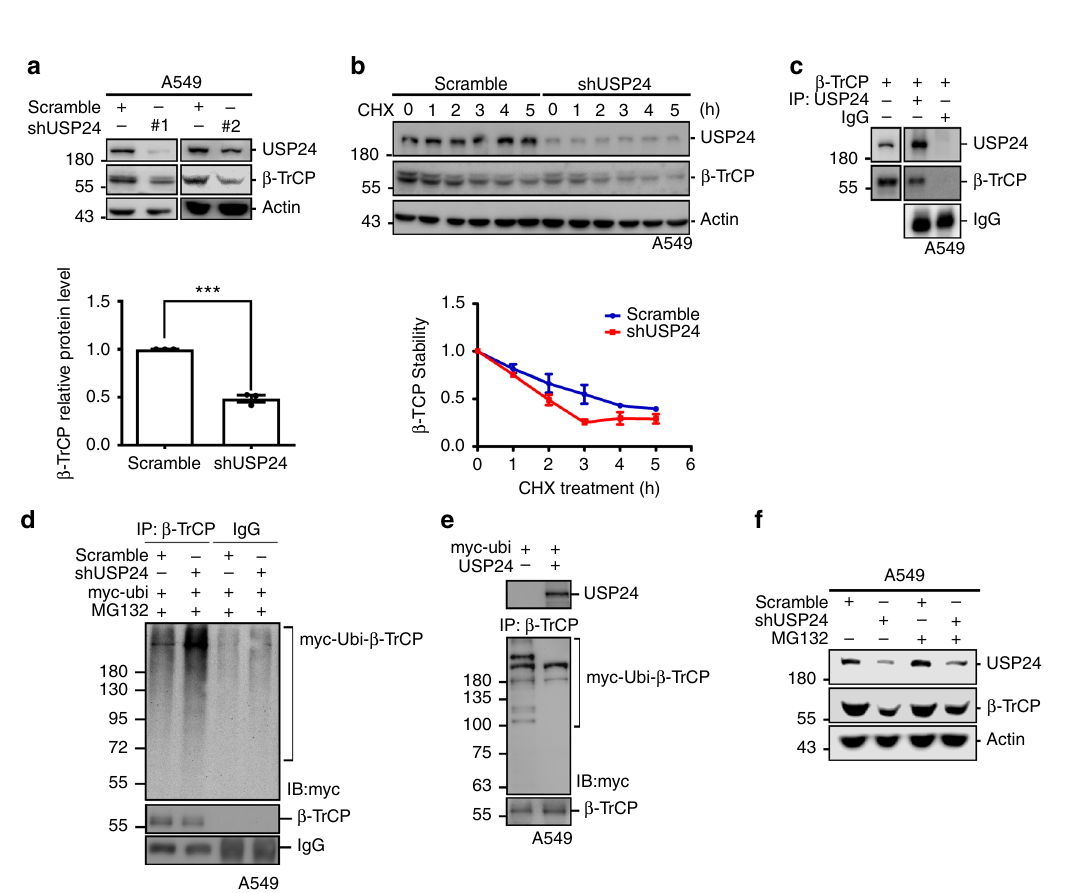
lung cancer (Fig. 8b). The signals from each protein were evaluated and assigned different scores to indicate the intensity of protein expression observed on the IHC slides after the validating the speci fi city of the indicated antibodies (Supplementary Fig. 6b). Samples with scores of 1 and 2 were considered low expression,